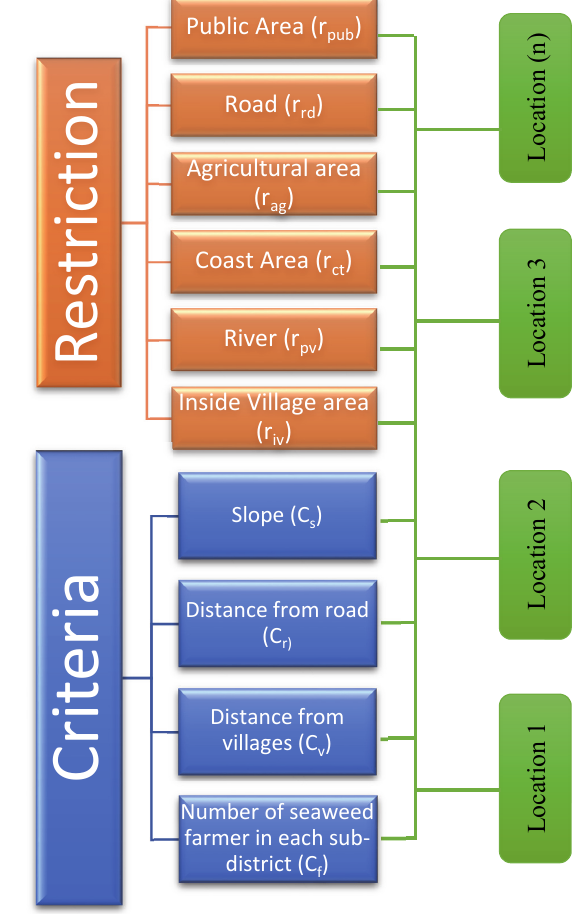
Fig. 3. Hierarchy decision criteria and restriction for information centre for seaweed